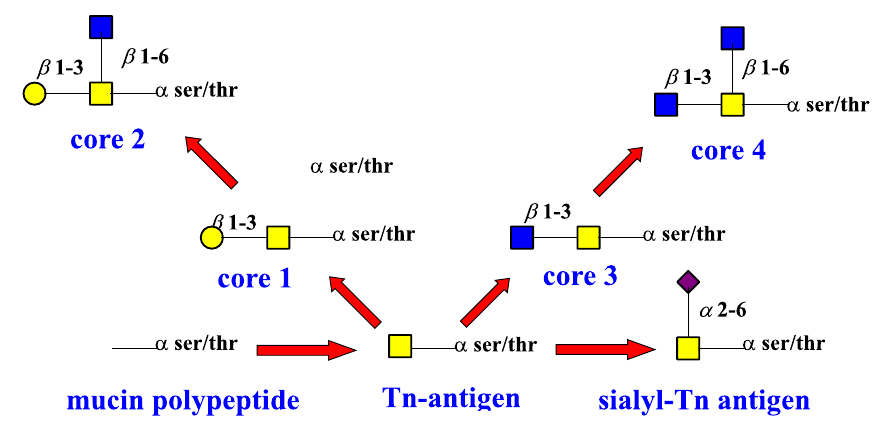
Figure 1. Biosynthetic Pathways leading to Mucin Core 1–4 Structures. Abbreviations and monosaccharide symbols are given at the end of the paper.